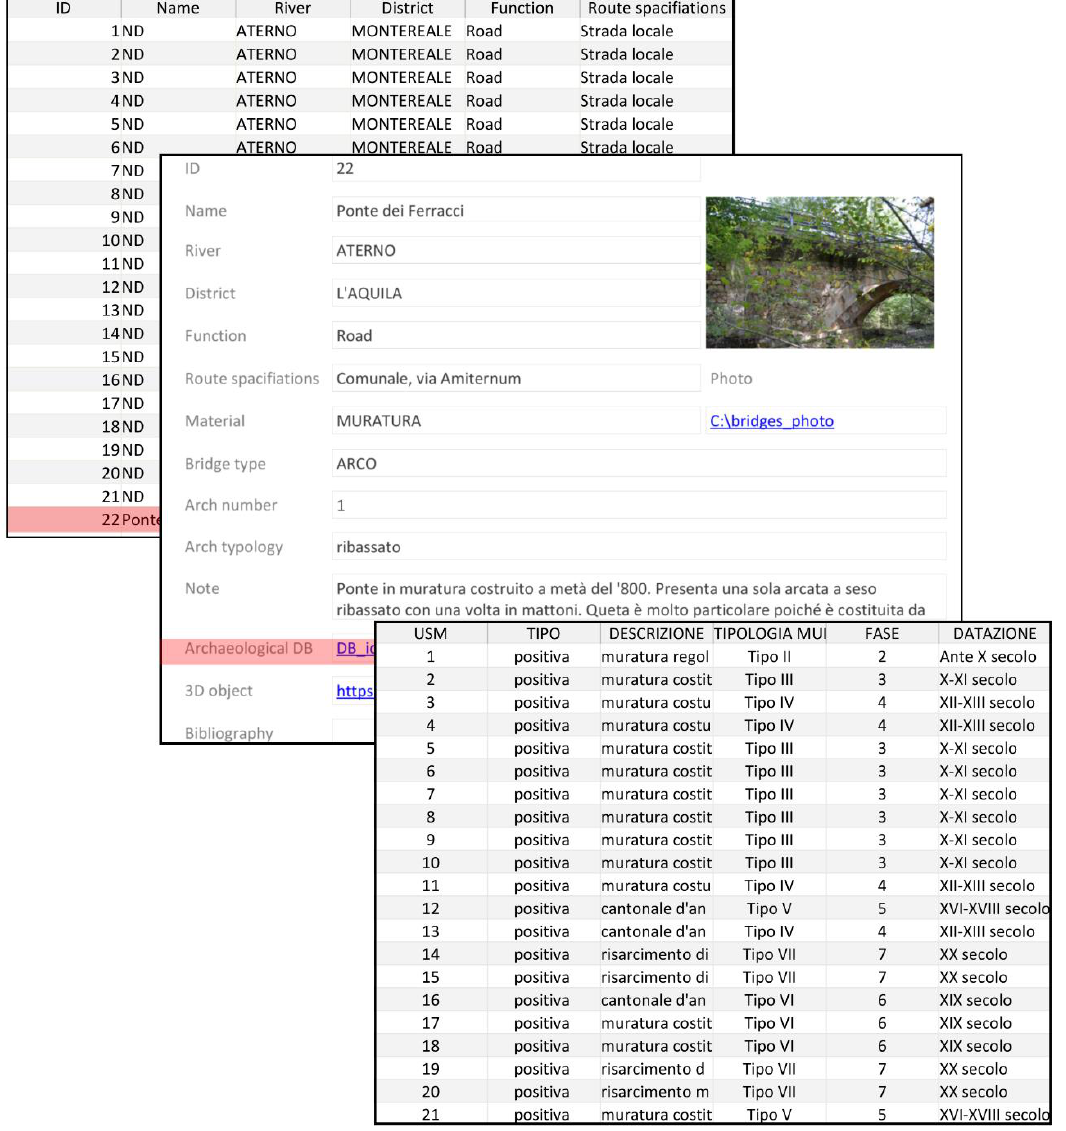
Figure 3. External relational database linked to the QGIS project.